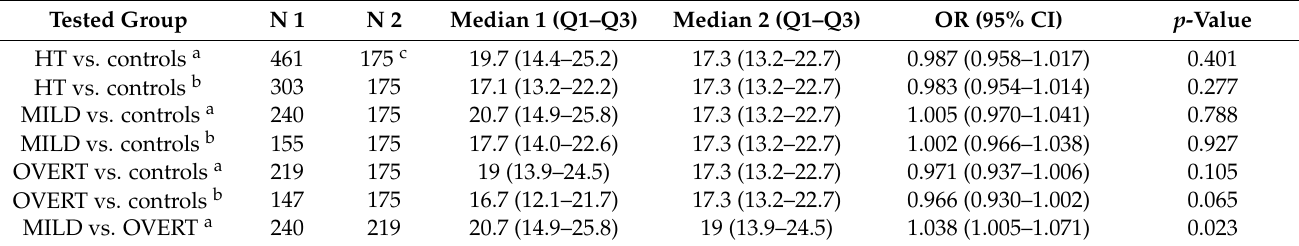
Table 2. Results of logistic regression for vitamin D levels between tested